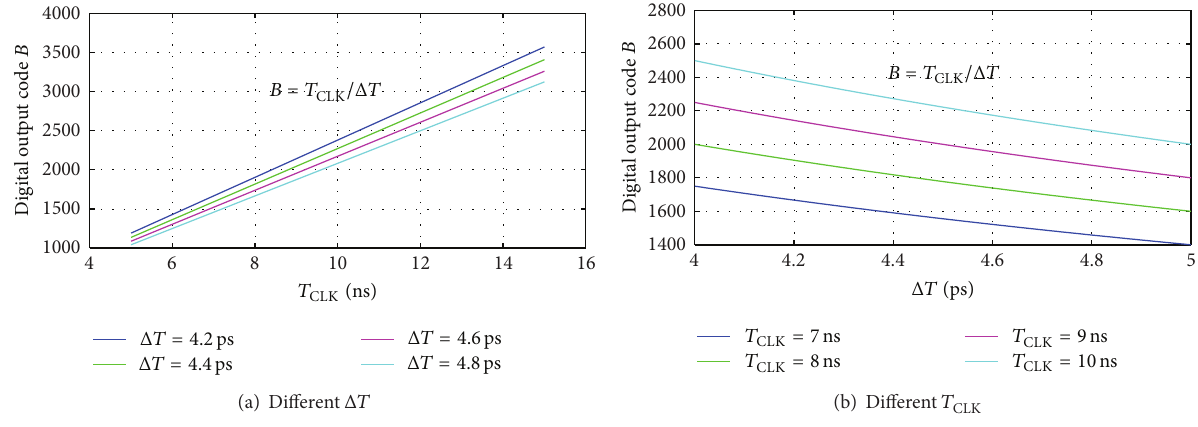
Figure 4: Simulated characteristic curves of the proposed TDC.